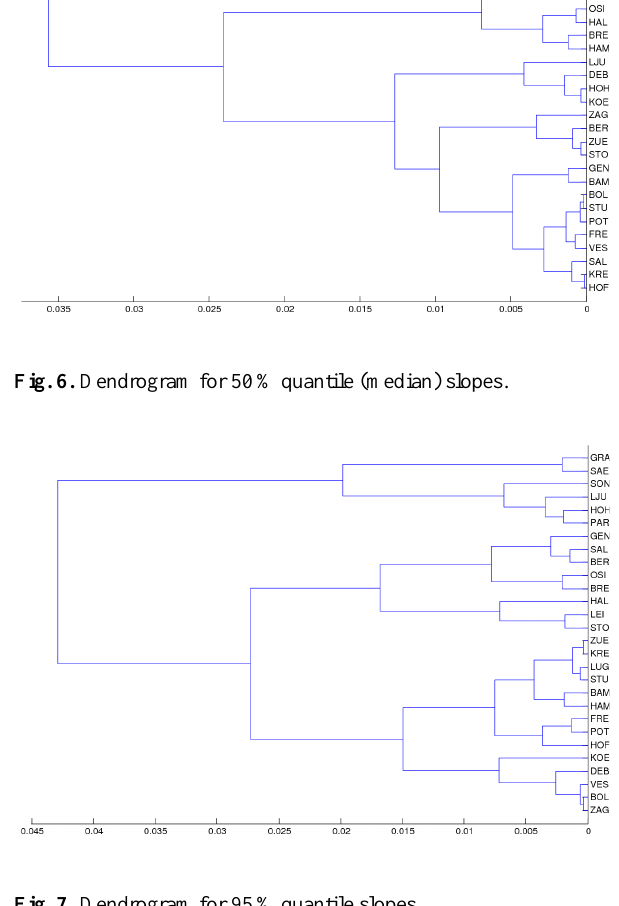
Fig. 7. Dendrogram for 95% quantile